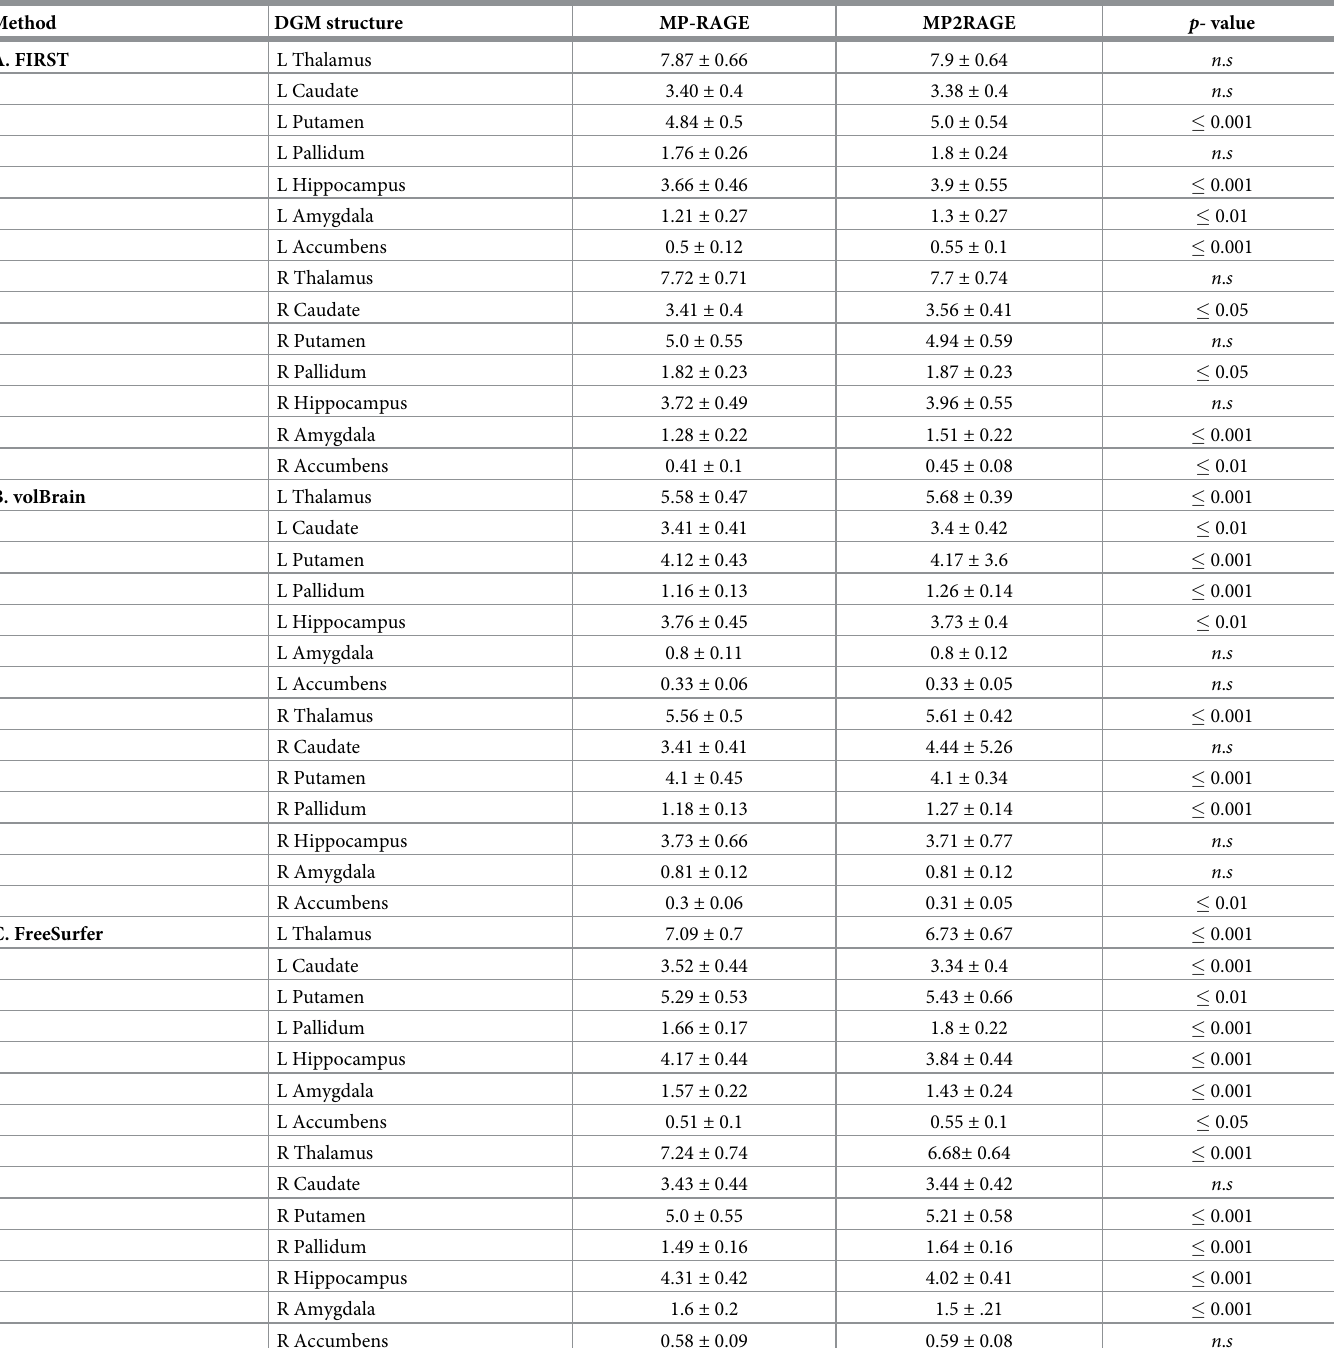
Table 3. Measured deep grey matter (DGM) structures volumes using the different segmentation tools based on MP-RAGE and MP2RAGE images.